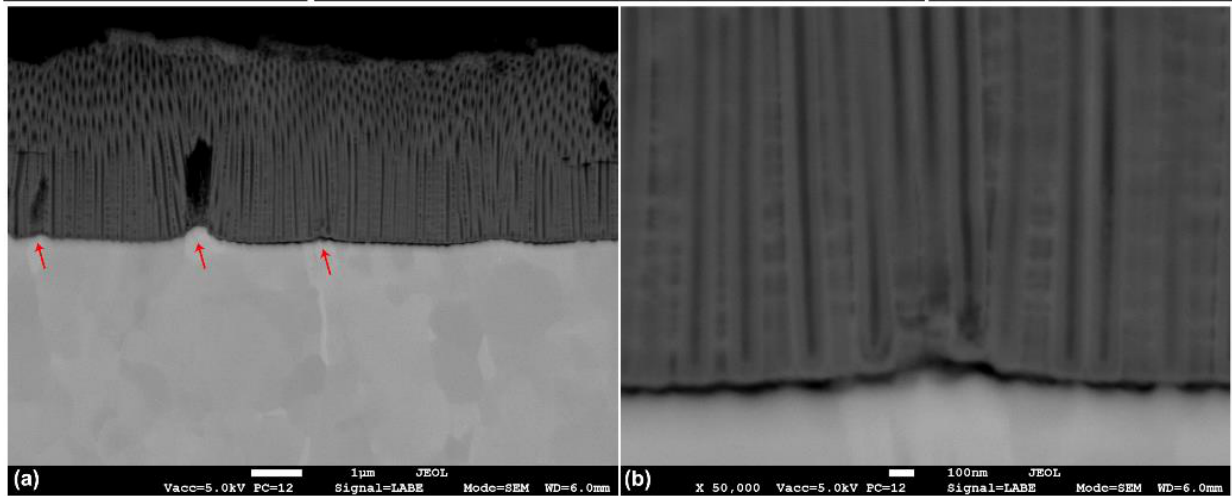
Figure 6. Cross section FESEM micrographs of samples anodized at 60 V for 60 min: ( a ) nanotubes over the two phases and ( b ) α -phase detail.